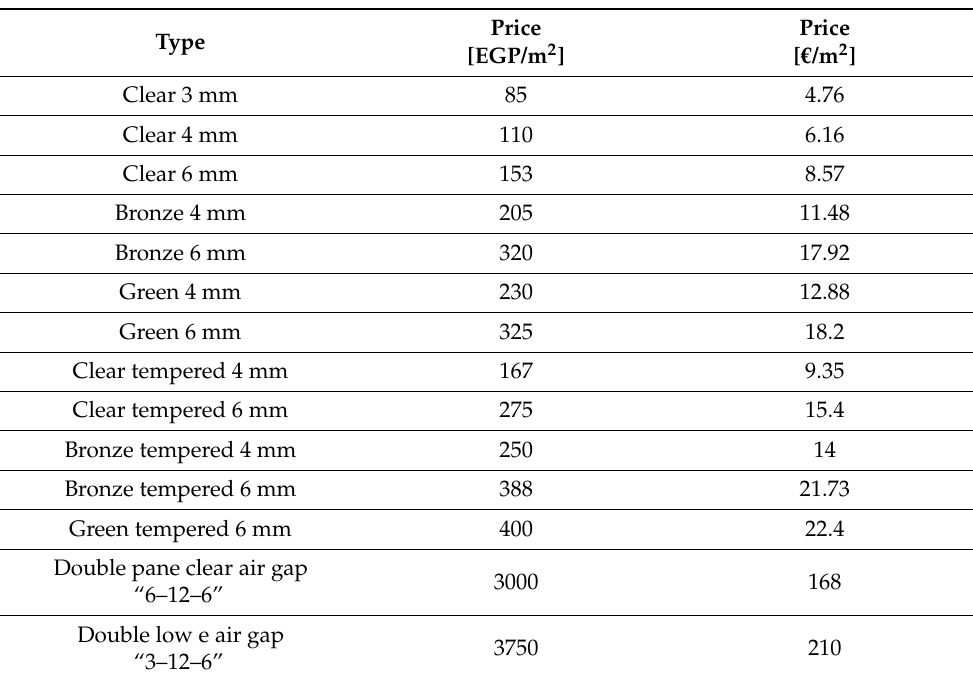
Table A3. List of different glazing types and